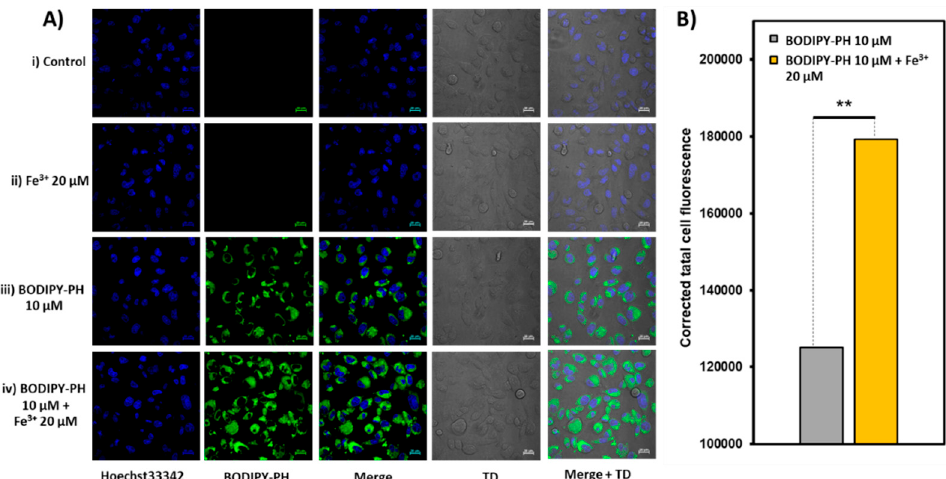
Figure 14. ( A ) Confocal laser scanning microscopy (CLSM) images of HEK-293 cells. Row i, control HEK-293 cells with no treatment. Row ii, HEK-293 cells incubated with Fe 3+ (20 µM) for 30 min. Row iii, HEK-293 cells incubated with BODIPY-PH (10 µM) for 30 min. Row iv, HEK-293 cells incubated with Fe 3+ (20 µM) for 30 min and subsequently incubated with BODIPY-PH (10 µM) for another 30 min (For BODIPY-PH: λ ex = 488 nm, λ em = 509 nm, scale bar = 20 µm, TD = transmitted light differential interference contrast image). All images were collected at the same microscopy settings. ( B ) Bar chart showing corrected total cell fluorescence (CTCF) of HEK-293 cells incubated with BODIPY-PH (10 µM) before and after the addition of Fe 3+ (20 µM). Statistical analysis is based on student’s two tailed t-test (* p < 0.05, ** p < 0.01, *** p < 0.001).